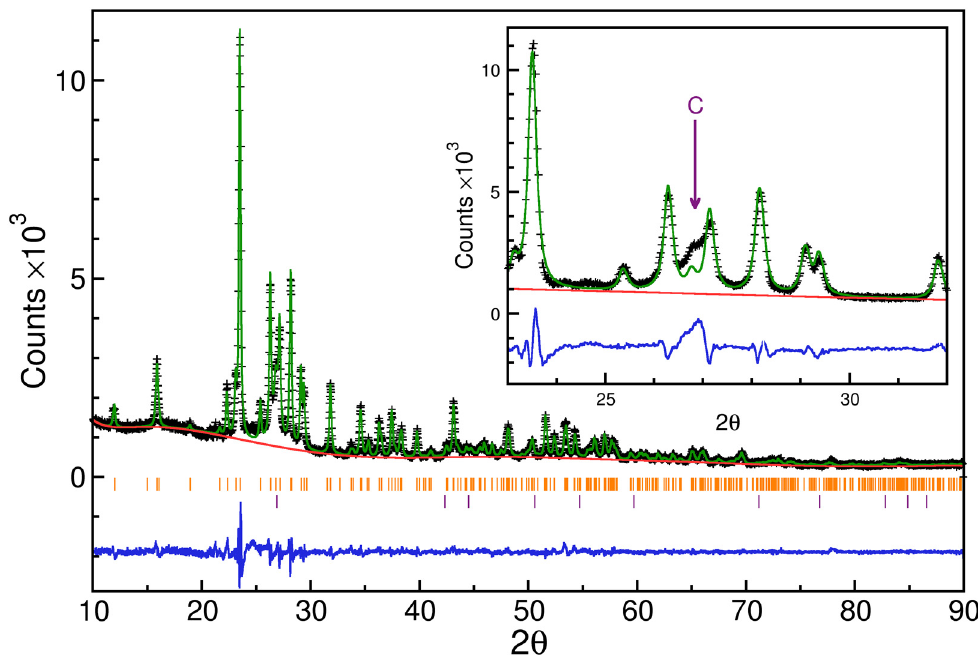
Figure 3. X-ray diffraction pattern for S@RGO/GN showing experimental data (black), Rietveld fit (green), background (red), and difference (blue). Tick marks indicate diffraction peak positions for alpha-sulfur (orange) and graphite (magenta). The inset shows the position of the principal carbon peak when graphite is omitted from the fit. Table 2. X-ray diffraction parameters for S@RGO/GN.